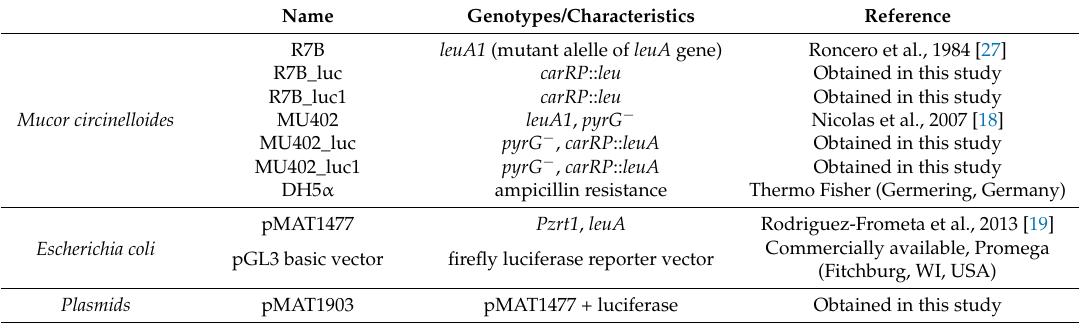
Table 1. List of strains and plasmids used in this